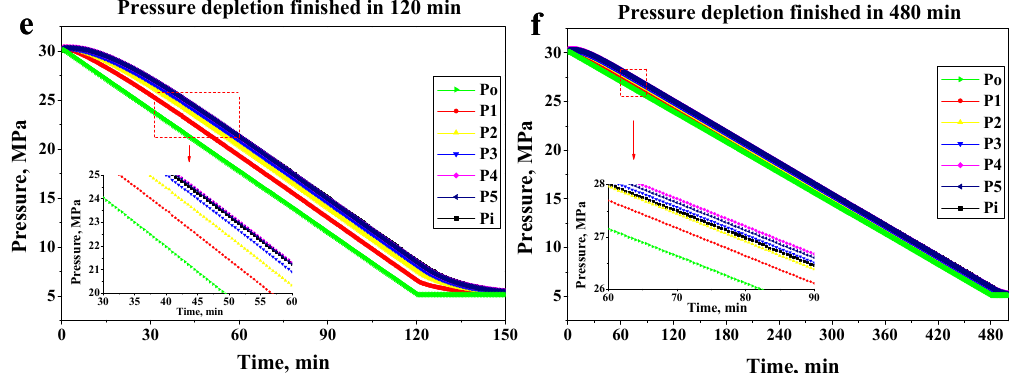
Figure 7. Characteristics diagram of pressure propagation during depletion experiments. ( a ) Pressure depletion finished in 0 min; ( b ) Pressure depletion finished in 1 min; ( c ) Pressure depletion finished in 10 min, ( d ) Pressure depletion finished in 60 min; ( e ) Pressure depletion finished in 120 min; ( f ) Pressure depletion finished in 480 min.